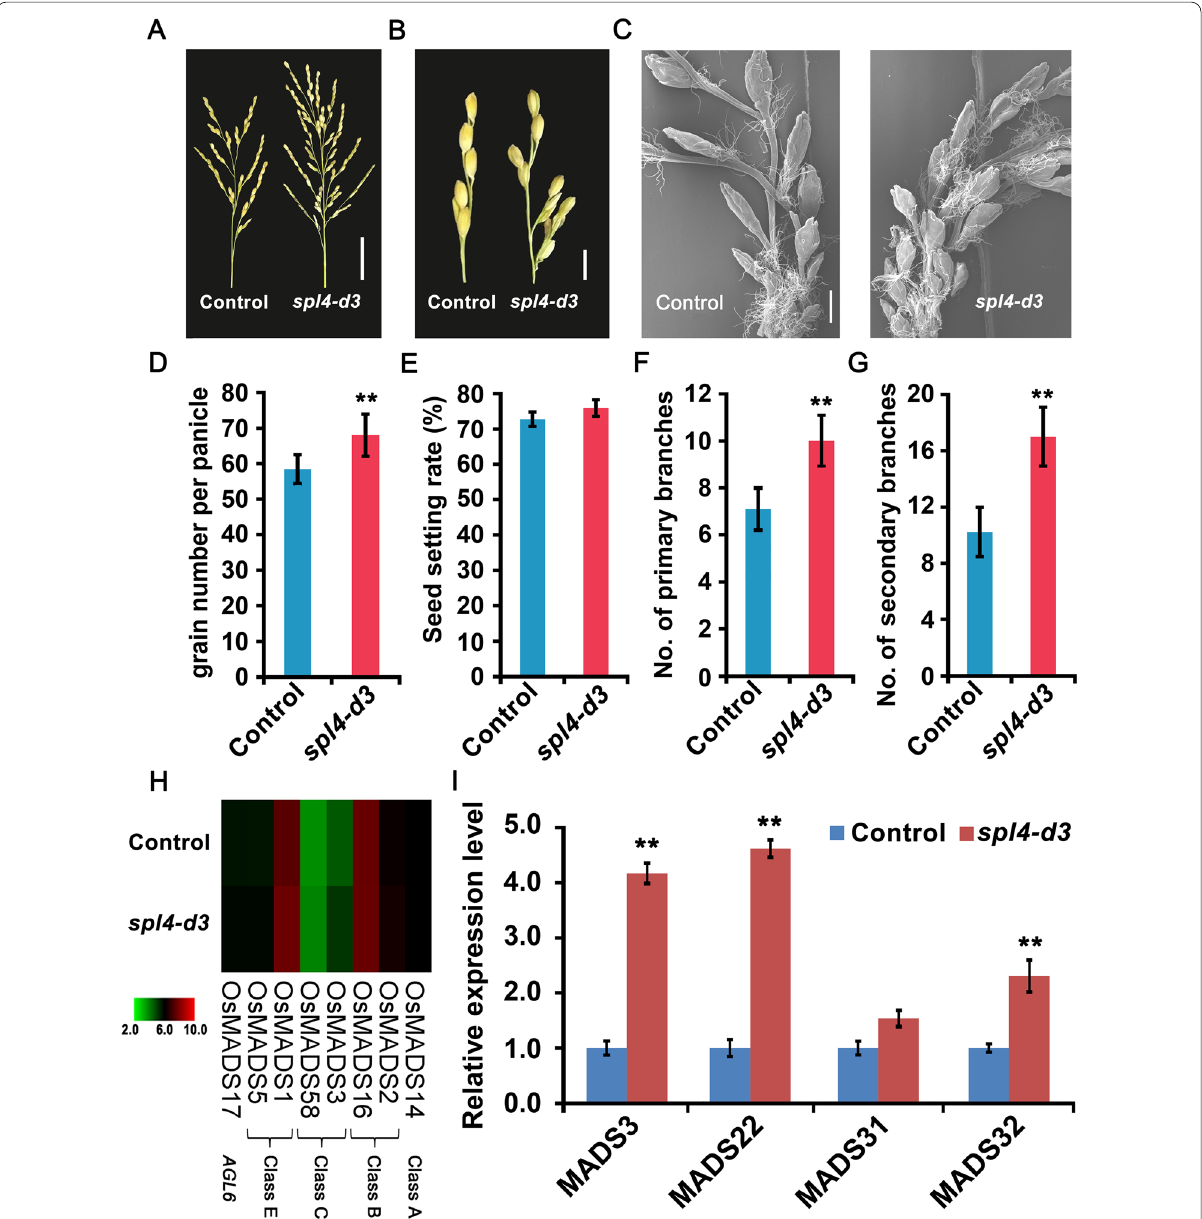
Fig. 5 Comparisons of the panicle morphologies of spl4-d3 transgenic plants with control plants. A Panicle architecture, scale bar Secondary branch, scale bar 1 cm. C Scanning electron micrographs of the young panicle, scale bar = setting rate. F Number of primary branches. G Number of secondary branches. H Heatmap of the expression patterns of the floral identity genes. I qRT-PCRs validation of the expression levels of some flower development genes ( MADS3 , MADS22 , MADS31 and MADS32 ) in spl4-d3 transgenic plants. Data were normalized to those of the control plants. Values are means * P < 0.05, ** P <